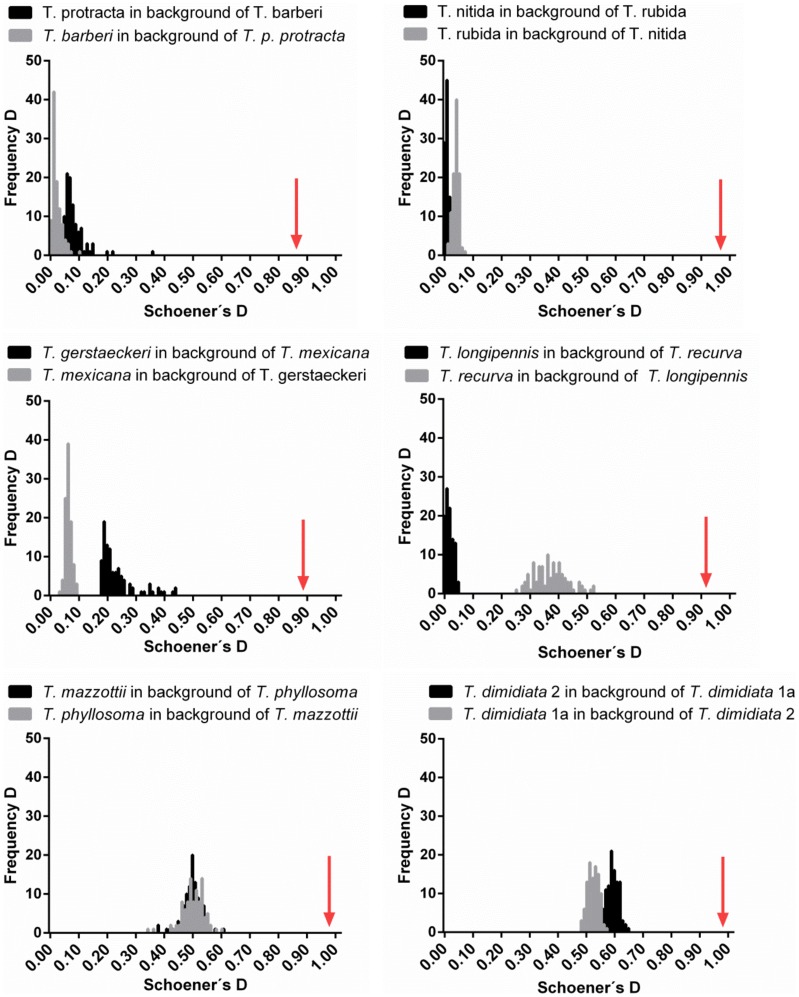
Ecological niche similarity tests between sister species pairs of NCA triatomines.Observed similarity between niches is indicated with the arrows, while bars indicate the null distribution of ecological niche distance generated randomly. Schoeners' D ranges from 0 (complete different ENM), to 1 (identical ENM). In all cases, the observed similarities were higher that their respective null distribution for random niche models.